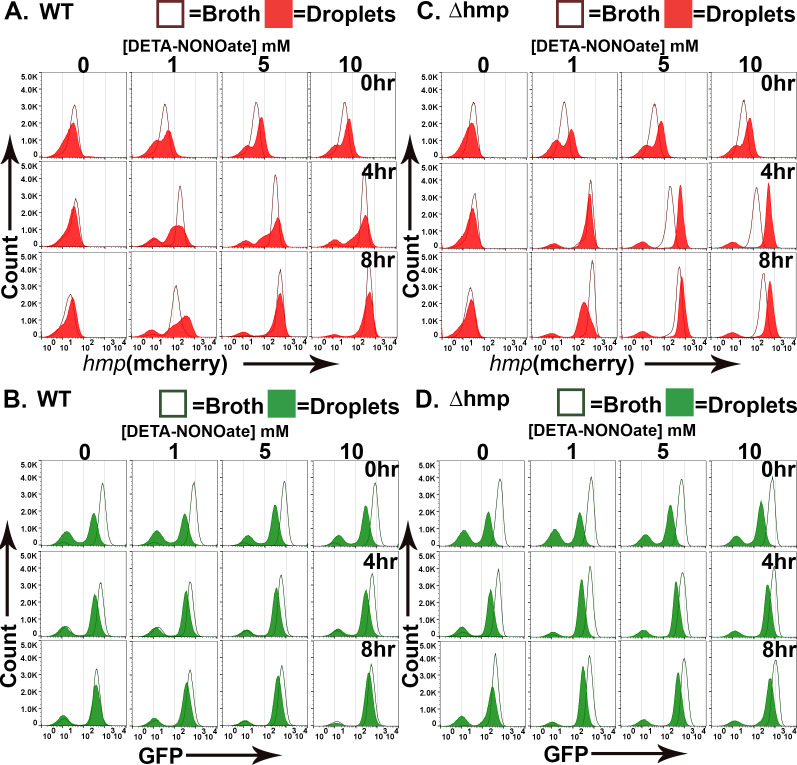
Topological constraints drive non-uniform expression of hmp.(A–D) Y. pseudotuberculosis grown in droplet microcolonies show altered response to NO. Noted bacterial strains harboring gfp+Phmp-mcherry plasmids were grown in either broth (open histograms) or droplets (filled histograms) in the presence of NO donor for the noted times. Droplet microcolonies were dispersed at noted times and analyzed by flow cytometry (Materials and methods). Histograms represent total ungated events. (A) Flow analysis of mCherry channel from WT. (B) Analysis of GFP channel from WT. (C) Flow analysis of mCherry channel from Δhmp. (D) Analysis of GFP channel from Δhmp.